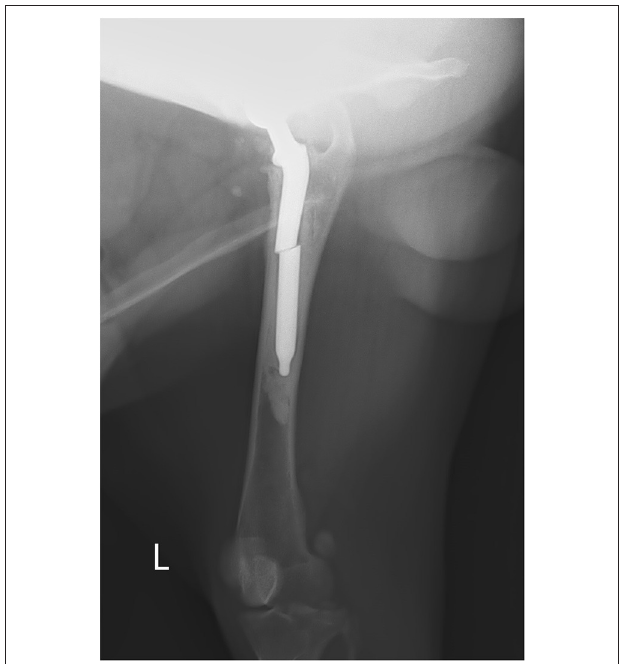
FIGURE 2 | Lateral radiograph with stem fracture in the midshaft—visible only in the lateral view. There is a dislocation in the middle part of the stem with a gap between the cuff cement and the stem, with mild periosteal reaction.